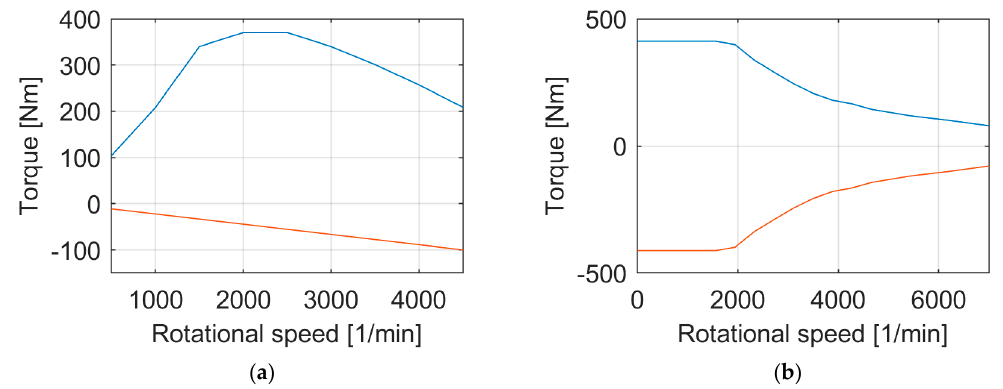
Figure 5. ( a ) Full-load characteristic curve (blue) and thrust characteristic curve (red) of the ICE model; ( b ) traction (blue) and generator (red) torque limits of the EM model.